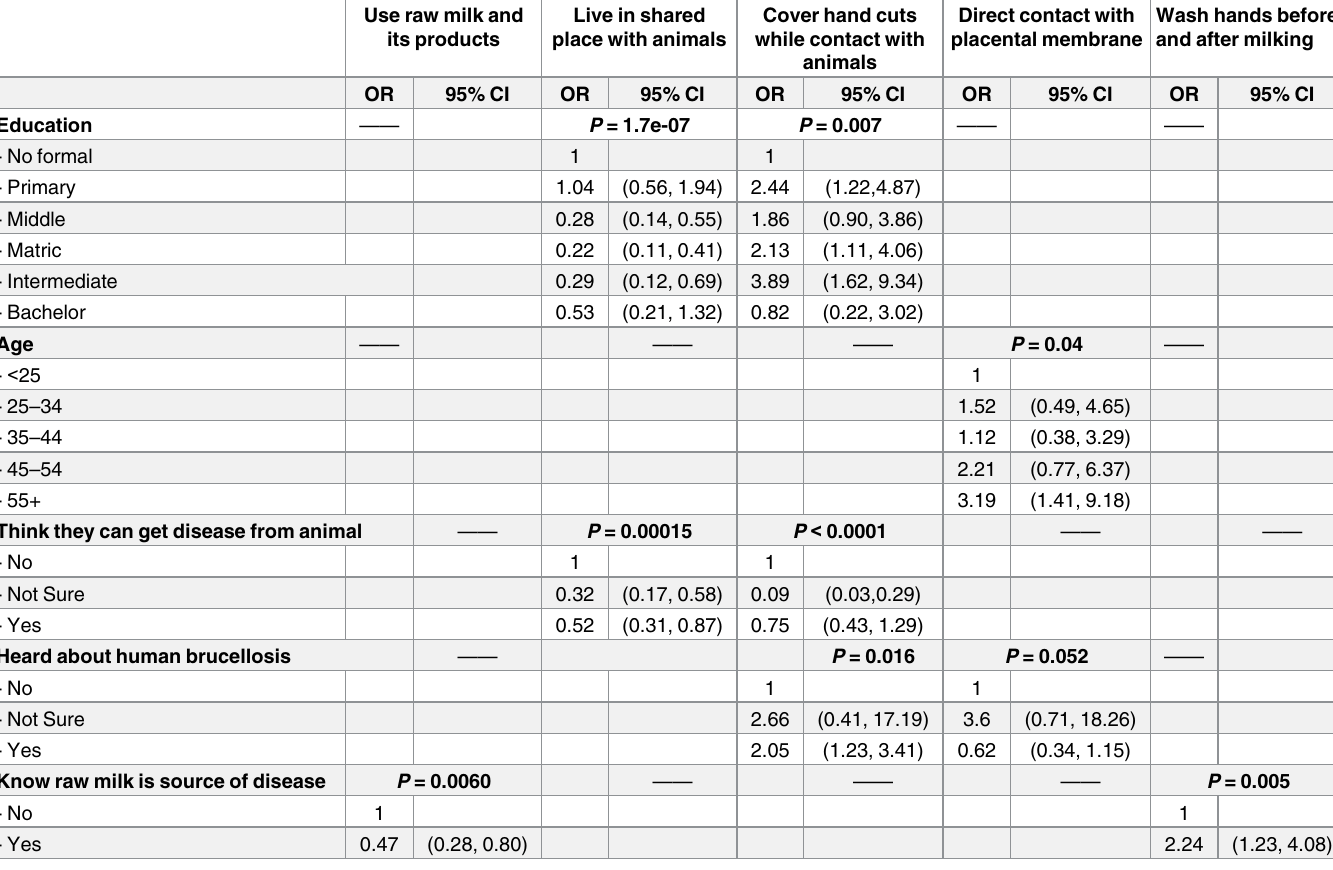
Table 10. Summaryof the final multivariable models for household risky practices. Columns of the table refer to specific practices (outcome variables) and rows refer to predictor variablesafter the backwardelimination process. P -valuesare shown for each predictor variable,followedby the odds ratio (OR) and 95% confidenceinterval(95% CI) for the OR, relative to the reference group (OR = 1). No entries (——) indicatewhere there was no significantassocia- tion in the final multivariable model.